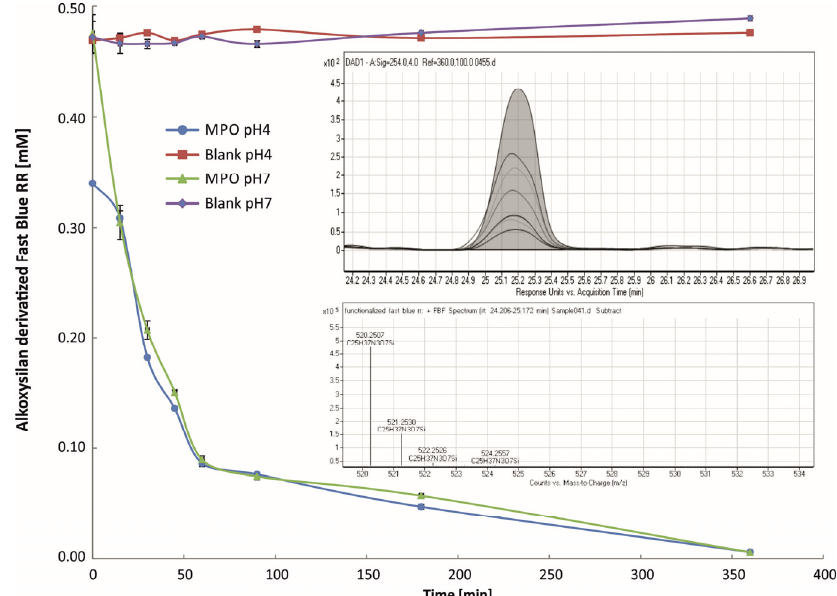
Figure 3. LC-MS TOF analysis of alkoxysilane-derivatized Fast Blue RR conversion by MPO: A substantial conversion of substrate could be observed already after several